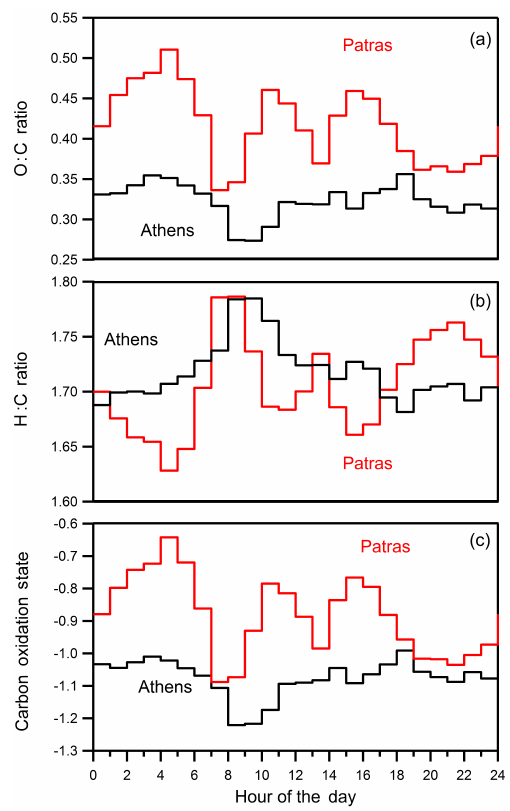
Figure 4. The diurnal profile of (a) the O:C ratio, (b) the H:C ratio, and (c) the OS C in Athens (black) and Patras (red). The ratios have been calculated following the Canagaratna et al. (2015)